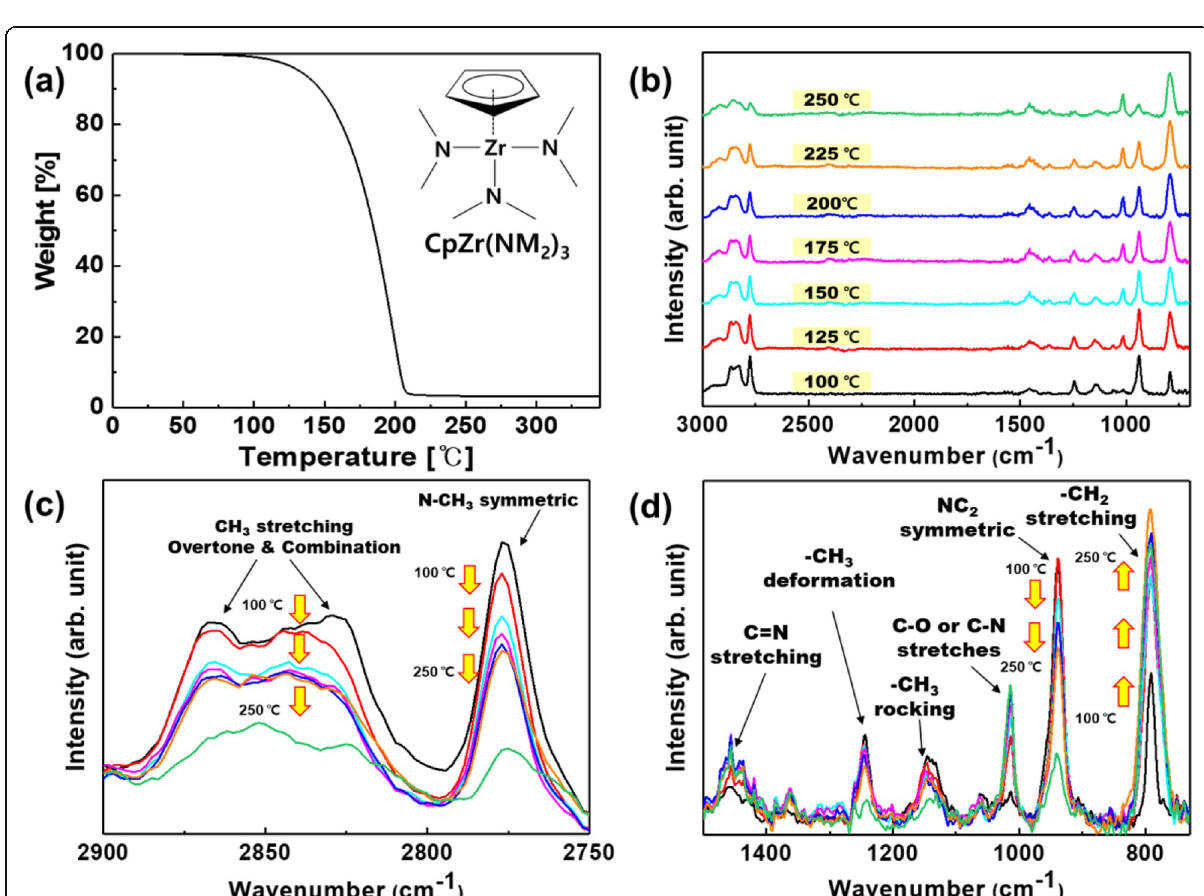
Fig. 2 TGA result with chemical structure and FT-IR spectrum from 100 to 250 °C of CpZr(NMe 2 ) 3 . a Chemical structure, FT-IR spectrum, b full range of 3000~700cm − 1 , c range of 3000~2750 cm − 1 , and d range of 1300~700cm −